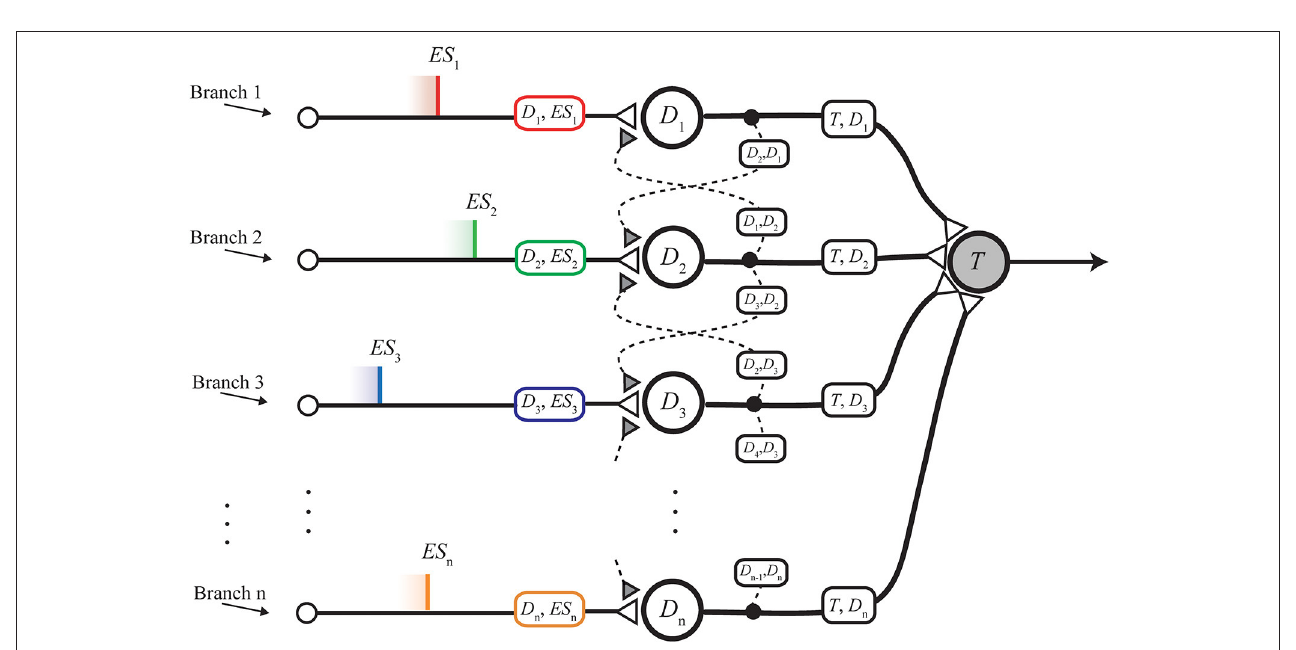
FIGURE 2 | nMNSD hit by a parallel spike